Question: Sum up the contents of this chart in one sentence.
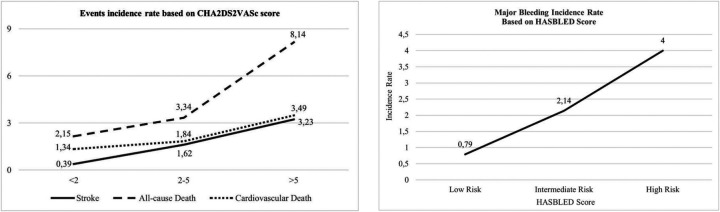
Answer: Events rate per 100 patient-years based on CHA 2 DS 2 -VASc score (left) and HASBLED score (right).